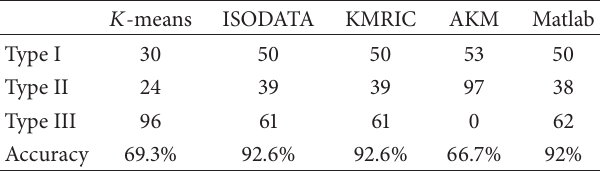
Table 1: Clustering method comparison under Iris dataset.